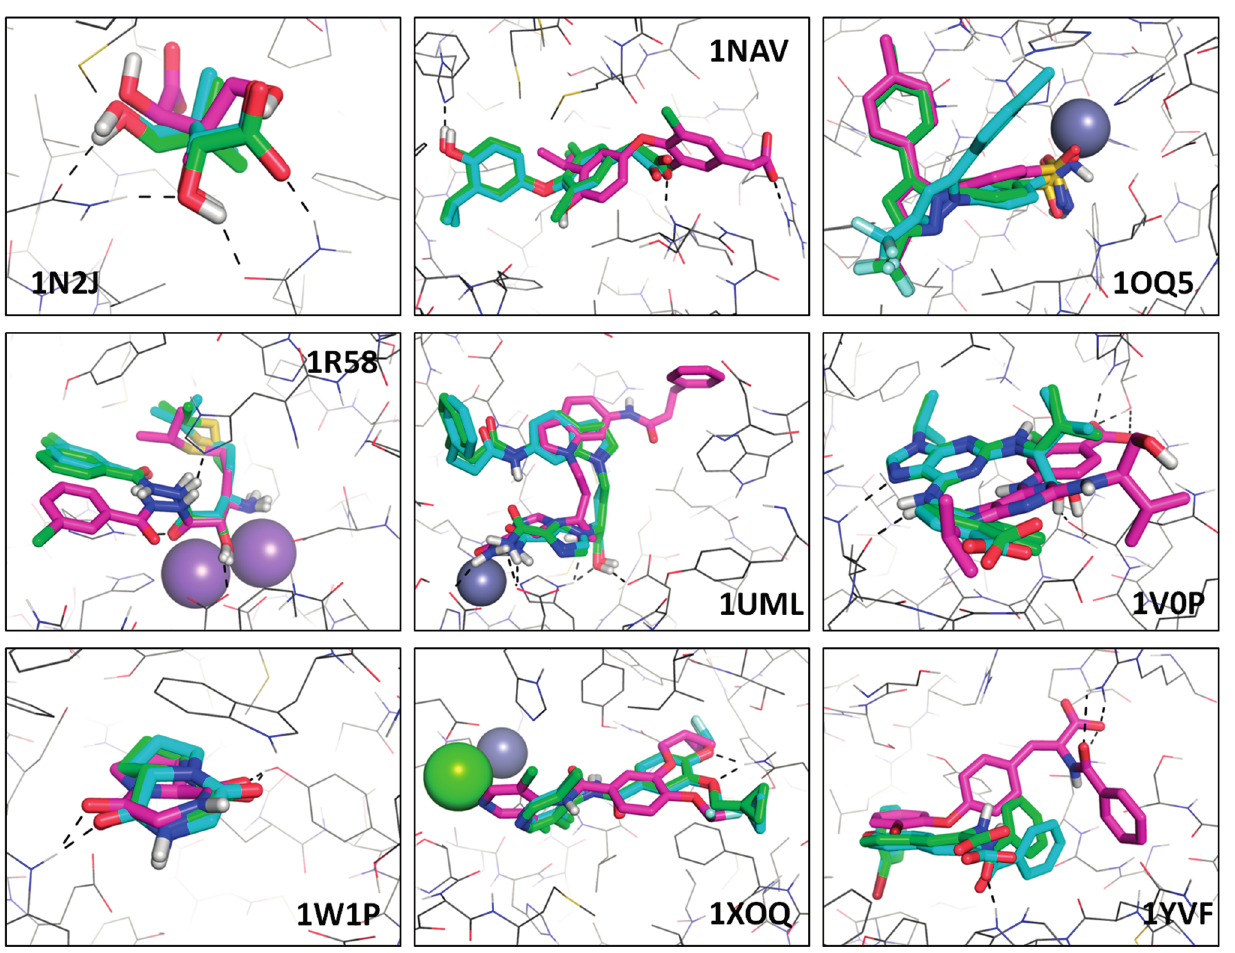
Figure 7. X-ray and top-ranked poses obtained using Fit FF and Core FF from the 9 PDB complexes discussed in the chapter §0 (Core vs. Fit). Native poses are shown in green, whereas Fit FF poses and Core FF are displayed in blue and purple respectively. Hydrogen-bonds are shown as black dotted line and ions are represented as